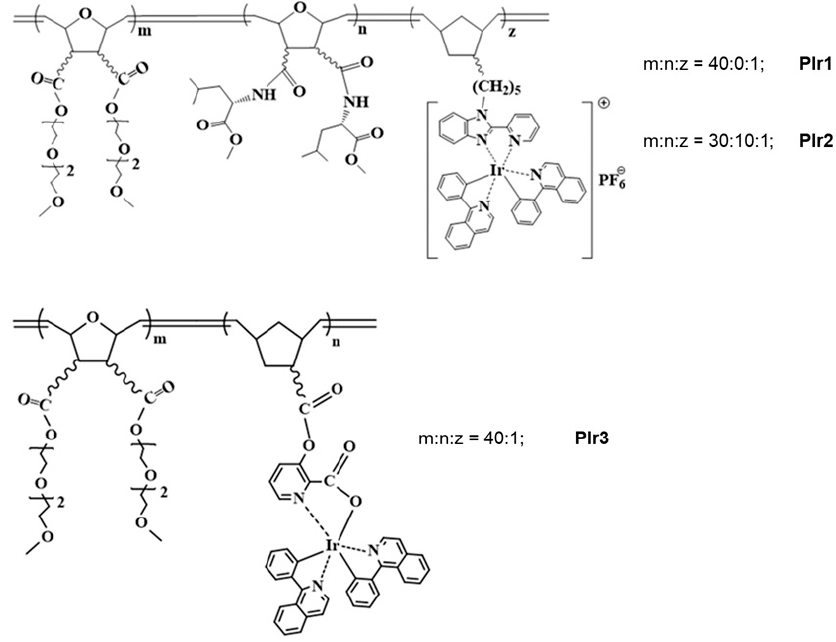
Figure 1. Chemical structures of the polymeric probes PIr1–PIr3.